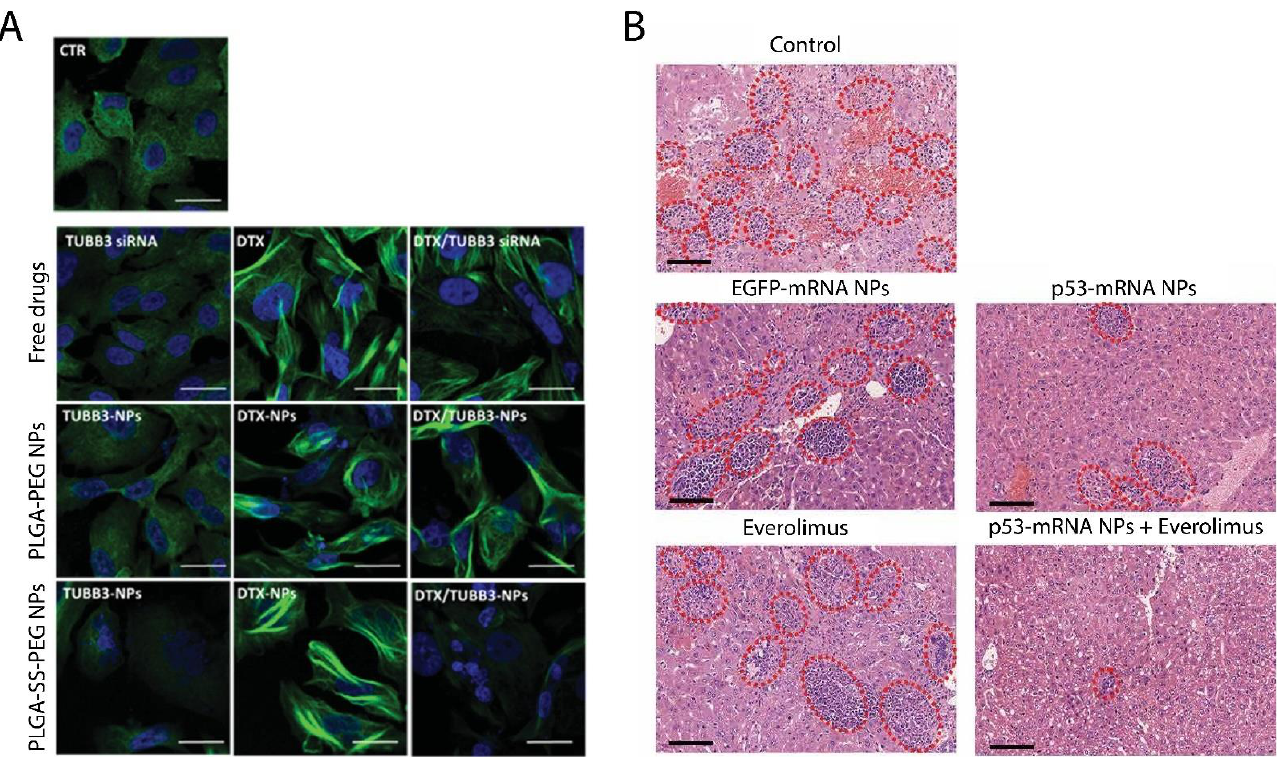
Figure 8. Redox-responsive NPs in combination with anticancer agents. ( A ) Immunofluorescence microscopy images of A549 tumor cells treated with PLGA-SS-PLGA, PLGA-PEG NPs, and free drugs ( β III-tubulin was stained in green and nuclei were stained with Hoechst 33,258 in blue). The scale bars indicate 10 µ m [100]. ( B ) Metastatic clusters (showed in red dotted ovals) in liver tissue after treatment with p53-mRNA NPs + everolimus, p53-mRNA NPs, everolimus, and EGFP-mRNA NPs. The scale bars represents 100 µ m [98].